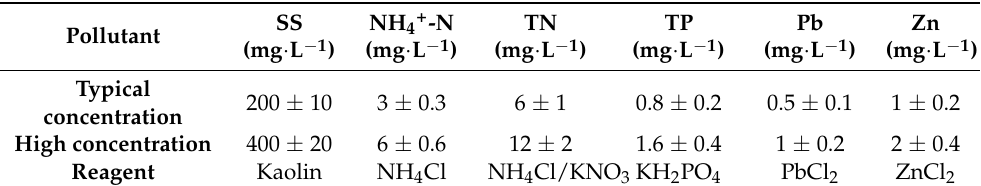
Table 1. Levels of pollutant concentrations used in artificial runoff in the study (mean ± standard deviation, n =